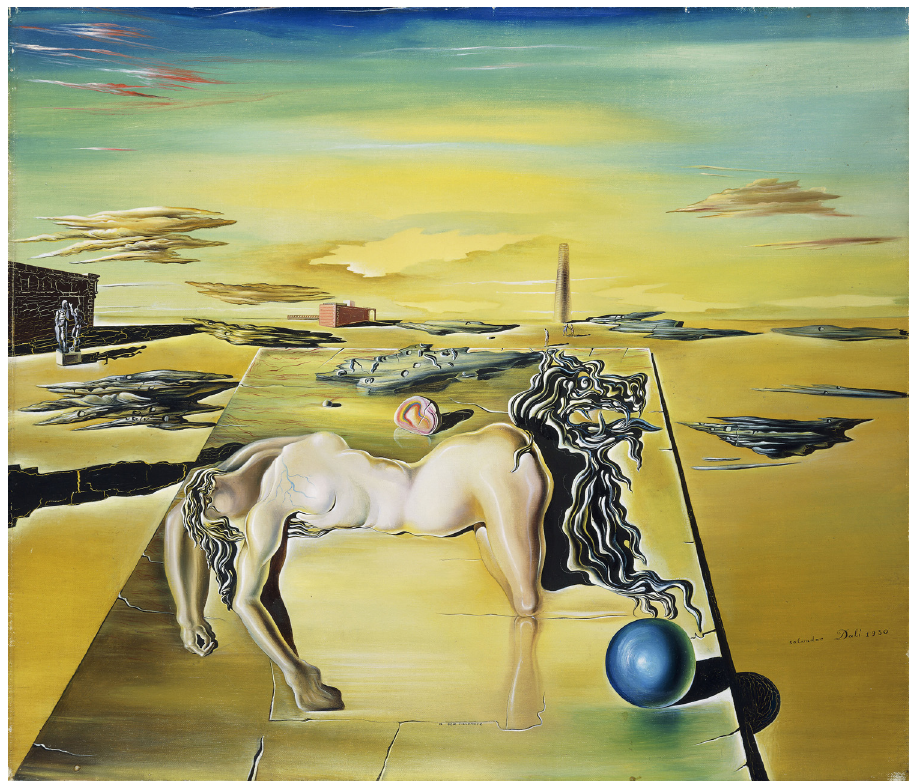
Figure 2: Salvador Dalí, 1930, Invisible Sleeping Woman, Horse, Lion , Pola Museum of Art, Pola Art Foundation,